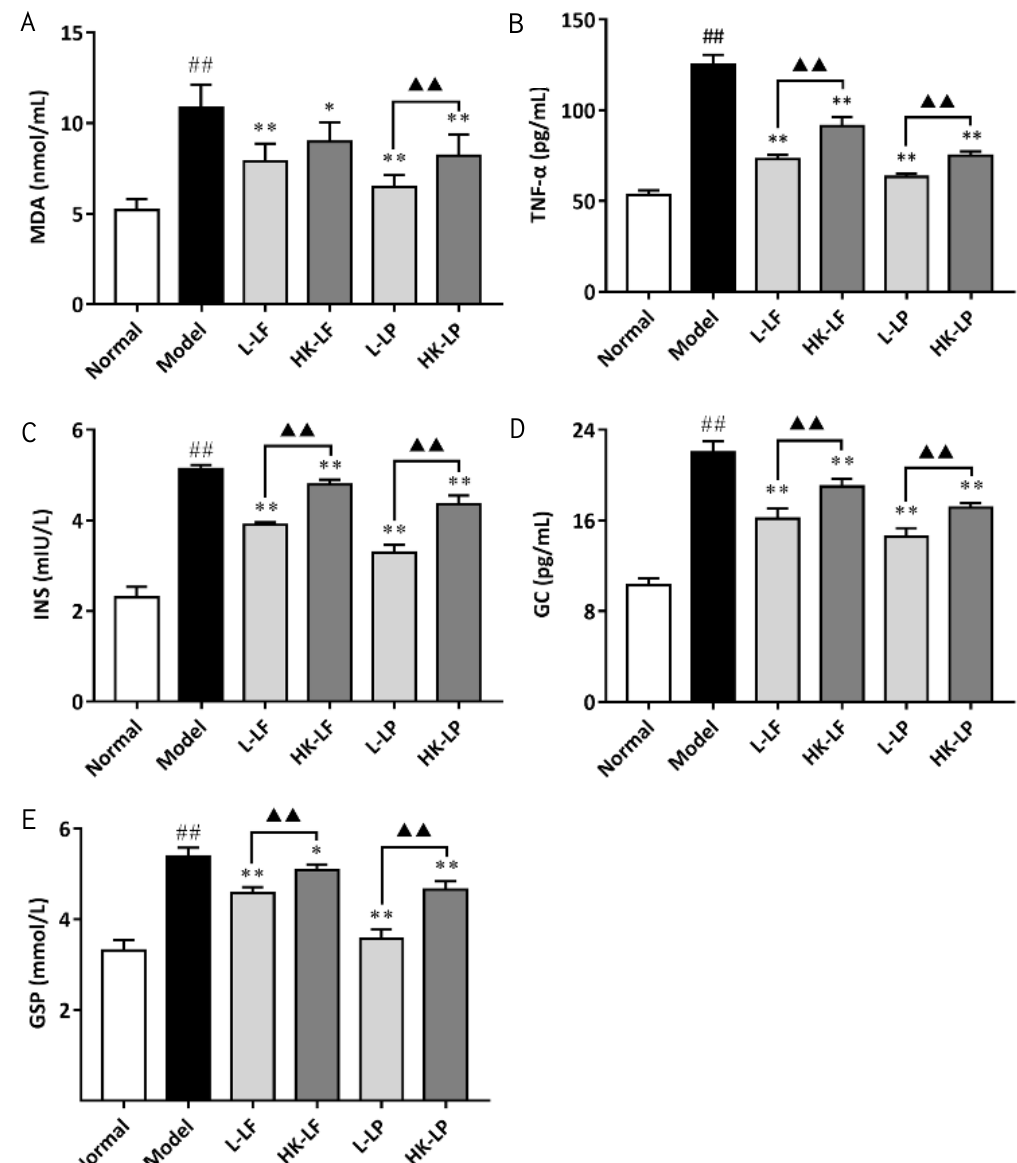
Figure 8. MDA (malondialdehyde) ( A ), TNF- α (tumor necrosis factor α ) ( B ), GSP (glycosylated serum protein ) ( C ), INS (insulin) ( D ), and GC (glucagon) ( E ) levels in serum. ## P < 0.01 compared with Normal, * P < 0.05 compared with Mode, ** P < 0.01 compared with Model, and